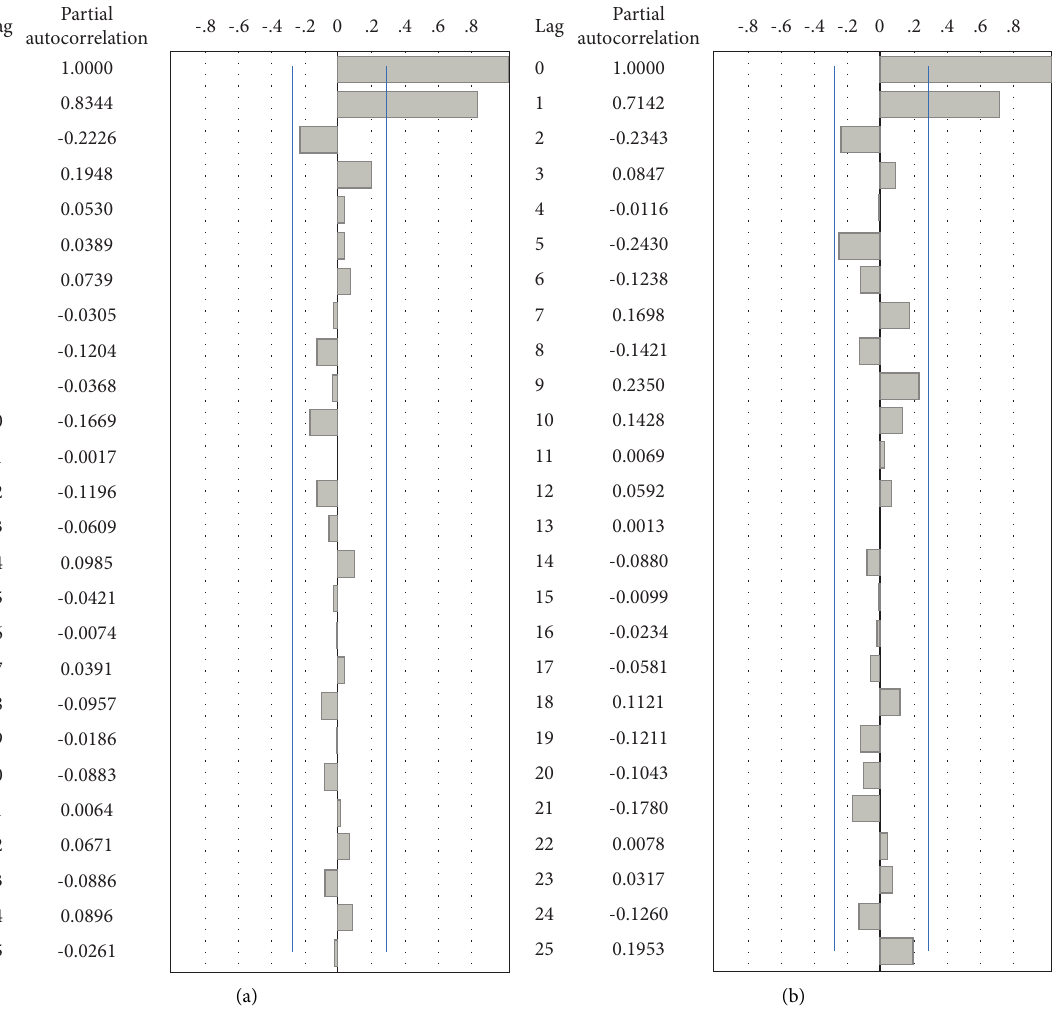
Figure 13: Partial autocorrelation coefcients of Fe 2 O 3 -asphalt model (a) and SiO 2 -asphalt model (b) in the OY direction.